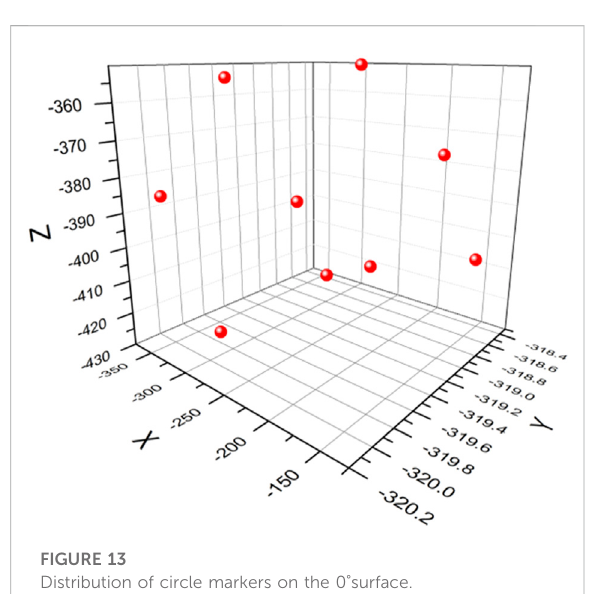
FIGURE 13 Distribution of circle markers on the 0 °